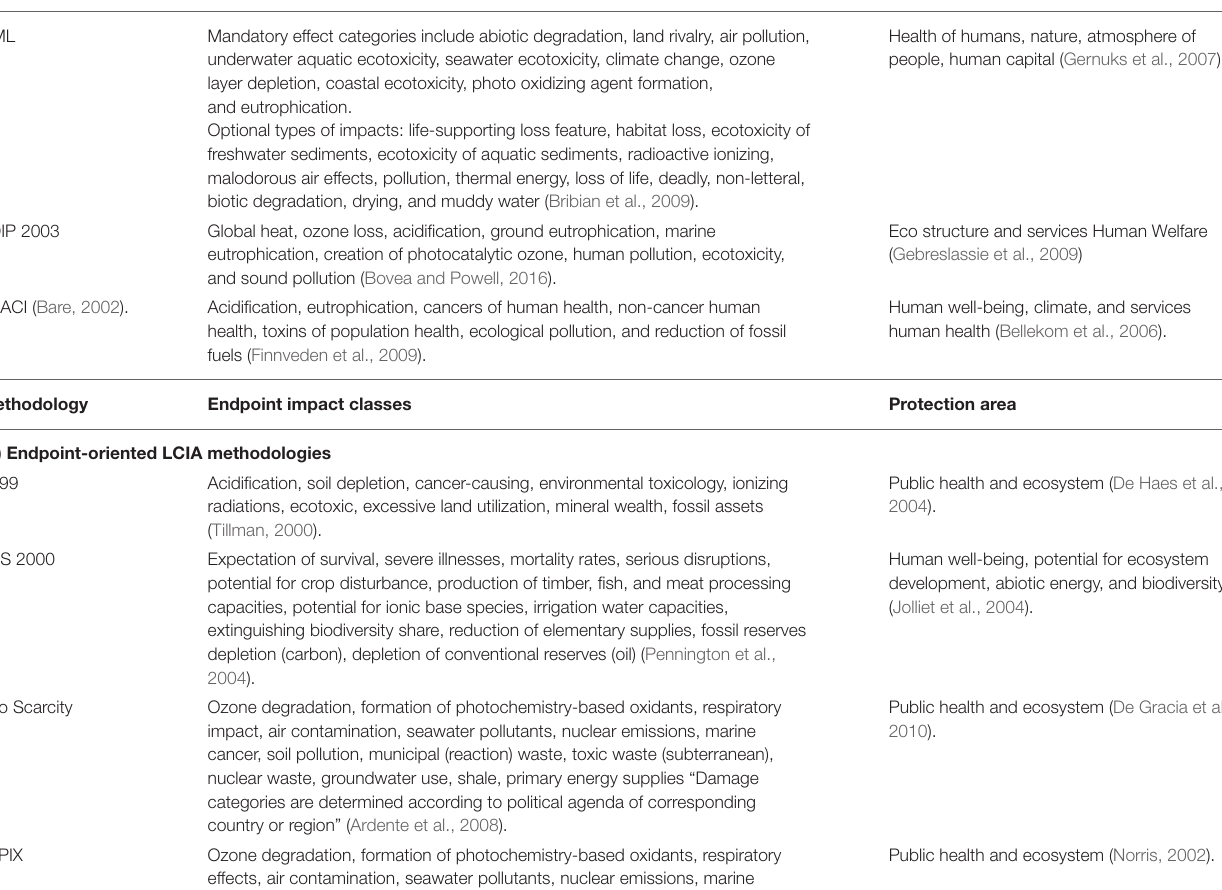
TABLE 1 | (A) Midpoint-oriented LCIA